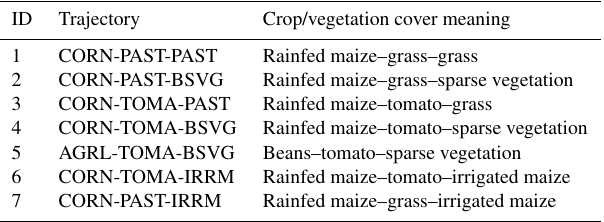
Table B1. Trajectories examples for each fake land use code use for dynamic SWAT + implementation.